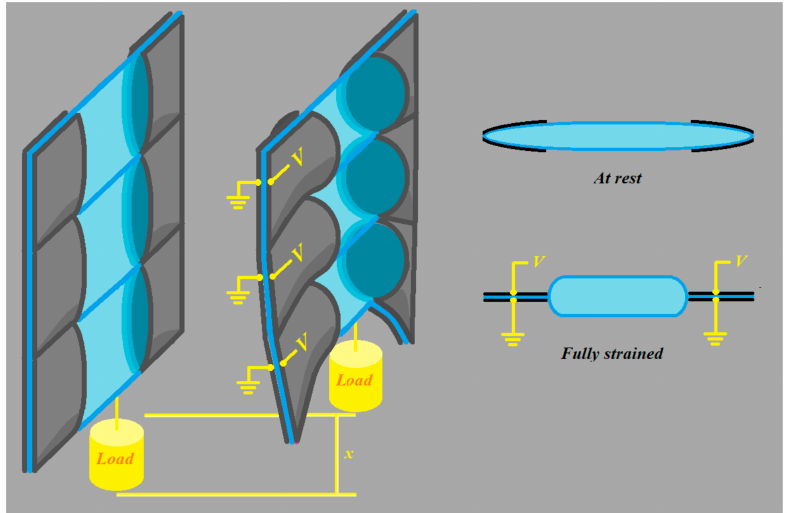
Figure 4. (Above) The high strain peano actuator from rest state to free strain condition